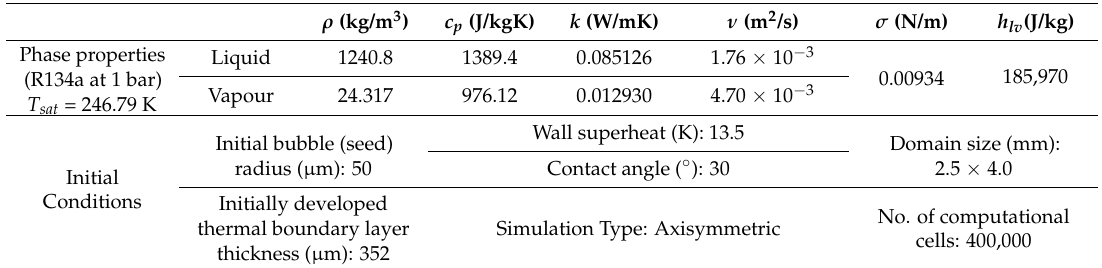
Table A6. Fluid properties and initial conditions (base case for R134a, at 5 bar).